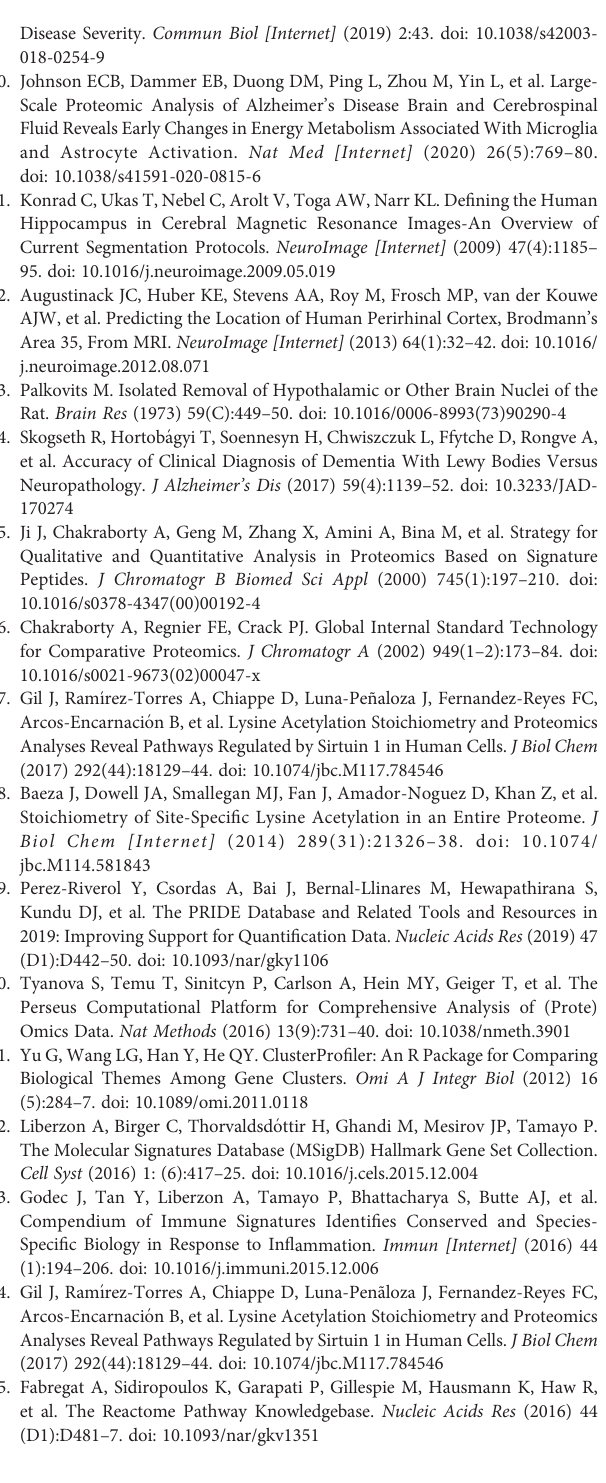
Supplementary Table 2 | Summary of the qualitative analysis. Supplementary Table 3 | Summary of the global proteome analysis. Supplementary Table 4 | Summary of the phosphopeptide analysis.